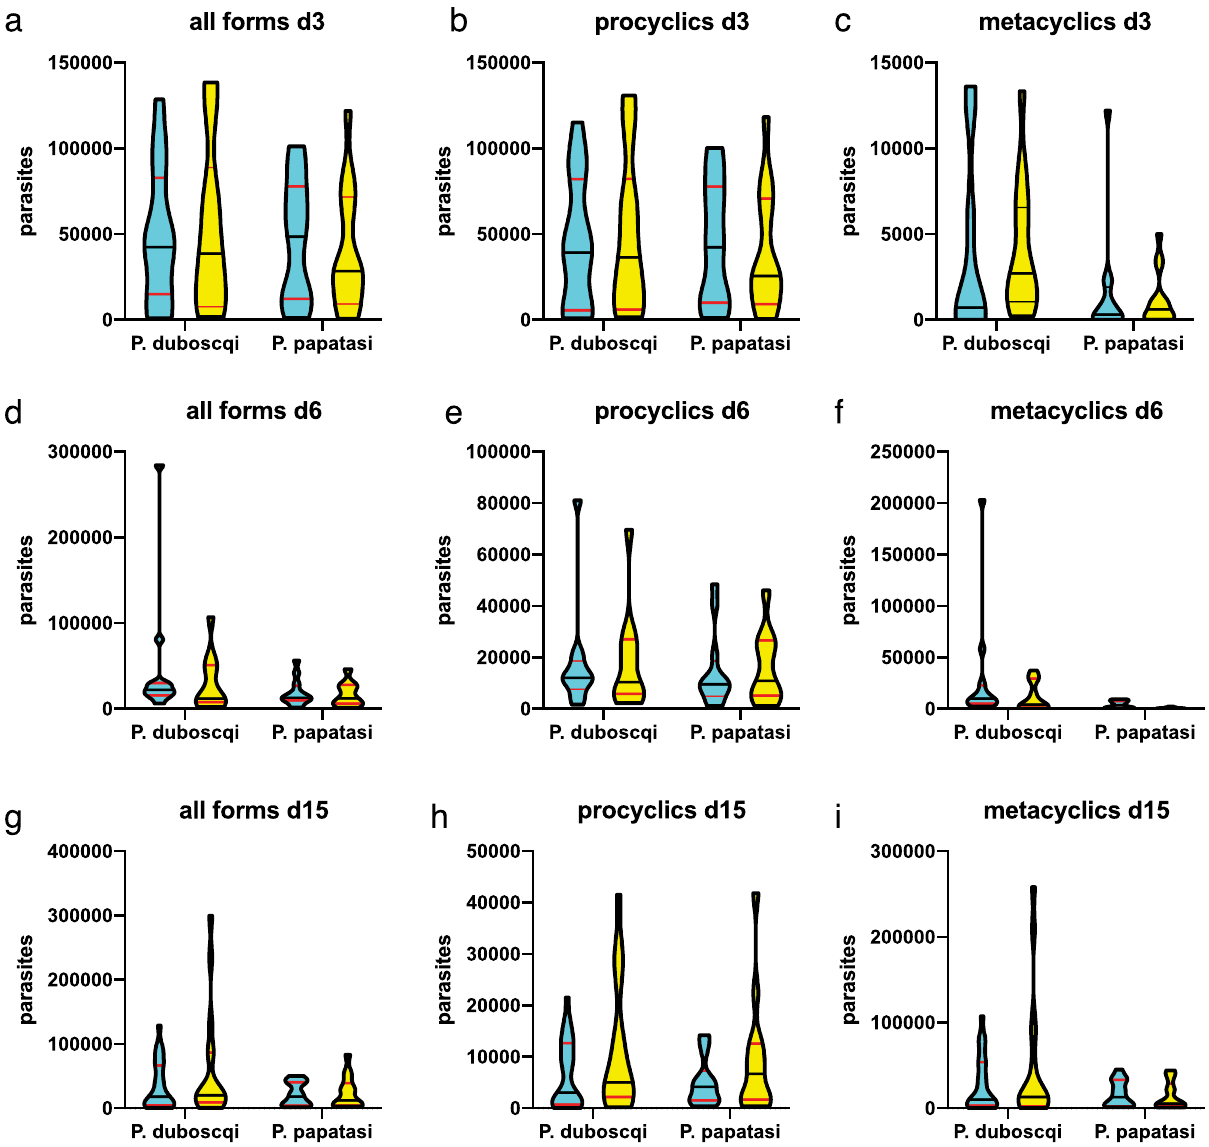
Fig. 6 Quantitative analysis of L. major MRC-01 and L. major MRC-02 development in sand fl ies. At the days indicated PBM, the number of L. major MRC-01 (blue) and L. major MRC-02 (yellow) parasites in engorged sand fl ies was quanti fi ed. a – c Parasite loads in sand fl ies at day 3 PBM. d – f , Parasite loads in sand fl ies at day 6 PBM. g – i Parasite loads in sand fl ies at day 15 PBM. Data are shown for all parasites (all forms, a , d , e ) and separately for procyclics ( b , e , h ) and metacyclics ( c , f , i ). Data are presented as violin plots truncated at the max/min values, with median (black line) and quartiles (red line) indicated and re fl ect counts obtained from 9 to 25 individual sand fl ies of each species dissected per time point for each infection. Source data and additional data can be found in Supplementary Data